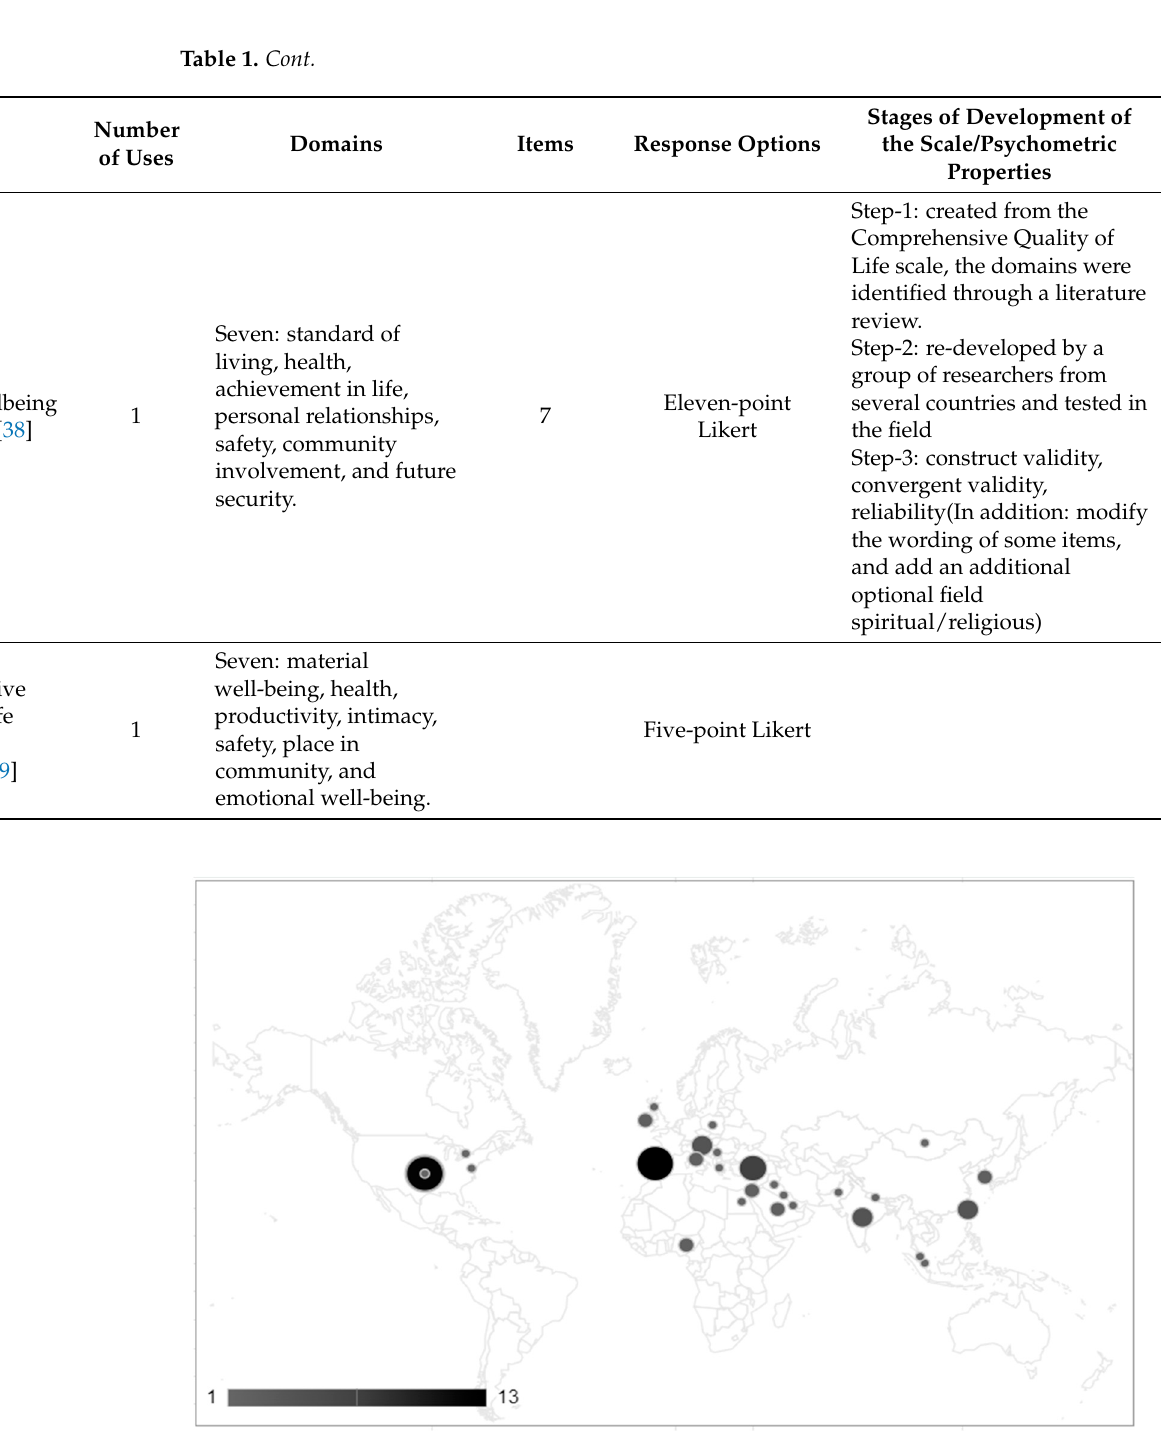
Figure 2. Map representing the samples from the different countries in the reviewed